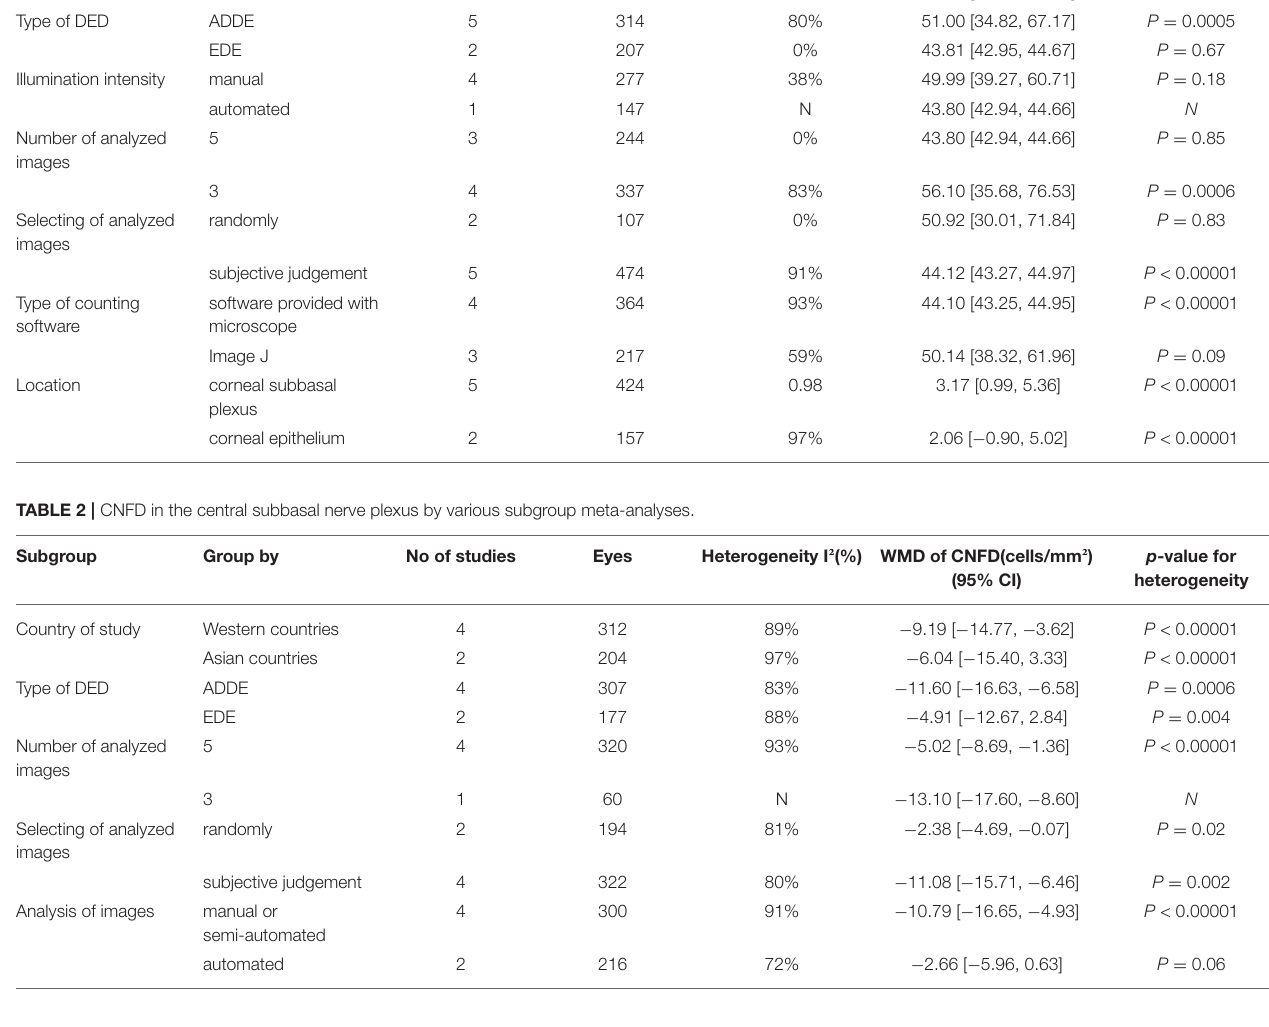
Country of study